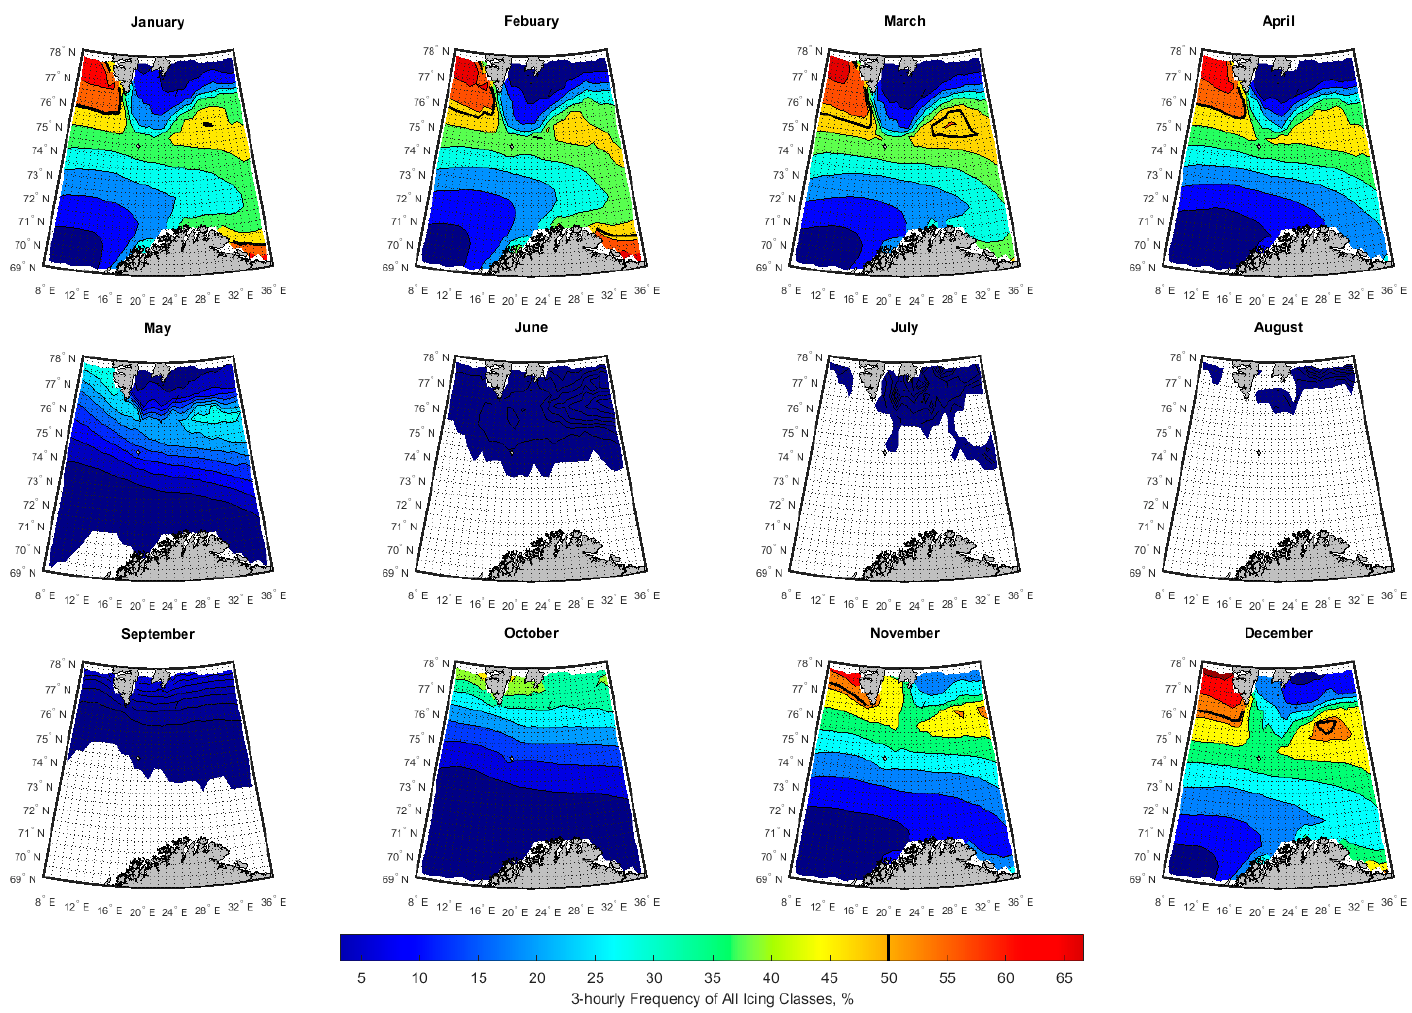
Figure 8. Three-hourly icing frequency (all icing classes) in each month. The black line represents the 50% frequency isoline.